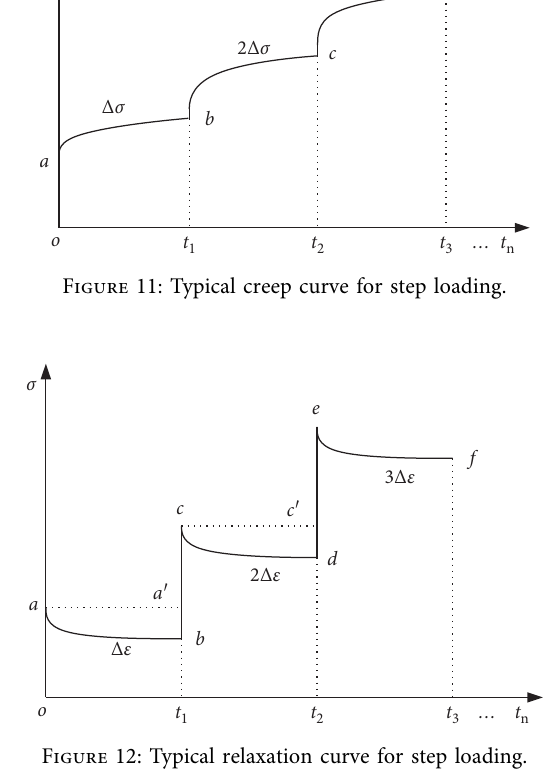
Figure 12: Typical relaxation curve for step loading.